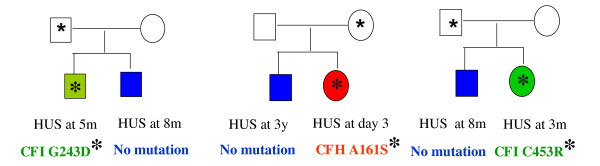
Unknown risk factor(s) to atypical hemolytic uremic syndrome can be associated with identified mutations: example from three families. In the 3 families, one child with aHUS has a mutation in CFH or CFI while a sibling also with aHUS has no mutation identified. Therefore the two siblings in each family share at least one unidentified risk factor. Affected individuals are indicated by filled symbols. Carriers of mutations are indicated by an asterisk. Courtesy of Professors R. Salomon (Hôpital Necker, Paris), E. Bérard (Hôpital de l'Archet, Nice) and G. Deschênes (Hôpital Robert Debré, Paris), with permission.